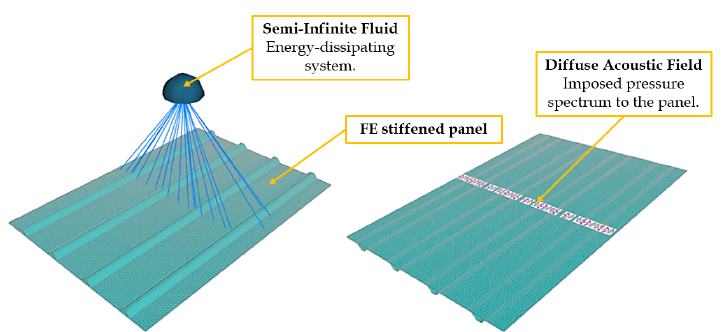
Figure 2. VAOne FEM